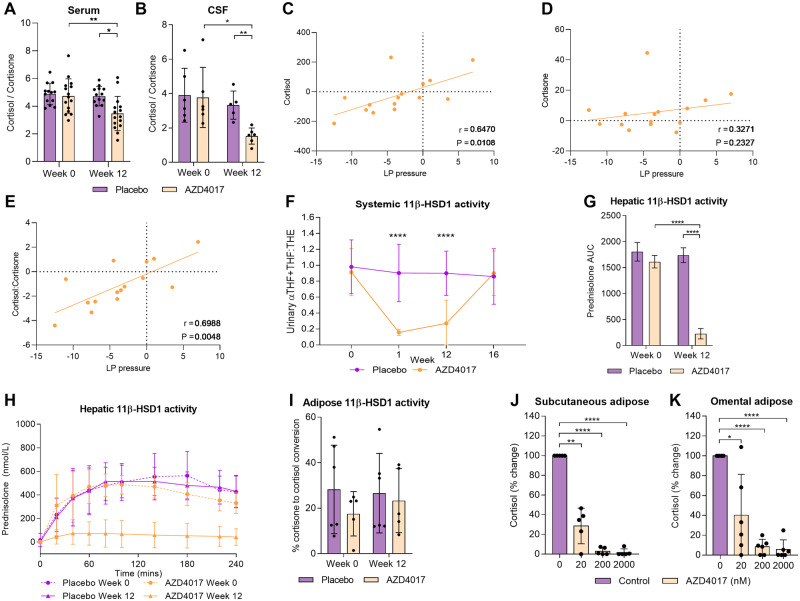

In vivo and ex vivo analyses of 11β-HSD activity after 12 weeks treatment with either AZD4017 or placebo. (A) Serum cortisol:cortisone ratio. (B) CSF cortisol:cortisone ratio. (C) Urinary 11β-HSD1 activity [(5α-THF + THF):THE] at Weeks 0, 1, 12 and 16. (D) Change in prednisolone AUC (see E). (E) Hepatic 11β-HSD1 activity (mean blood prednisolone concentration after conversion from prednisone) over 4 hours. (F) Subcutaneous adipose 11β-HSD1 activity (percentage change from cortisone to cortisol) ex vivo. (G) Ex vivo subcutaneous adipose. (H) Omental adipose 11β-HSD1 activity (cortisol production from cortisone) after 24 hours incubation with 0, 20, 200 or 2000 nM of AZD4017 in vitro. Data presented as mean ± SD. *P < 0.05, **P < 0.01, 0.001, ****P < 0.0001. AUC = area under the curve; 5α-THF = 5α-tetrahydrocortisol; THE = tetrahydrocortisone; THF = tetrahydrocortisol.